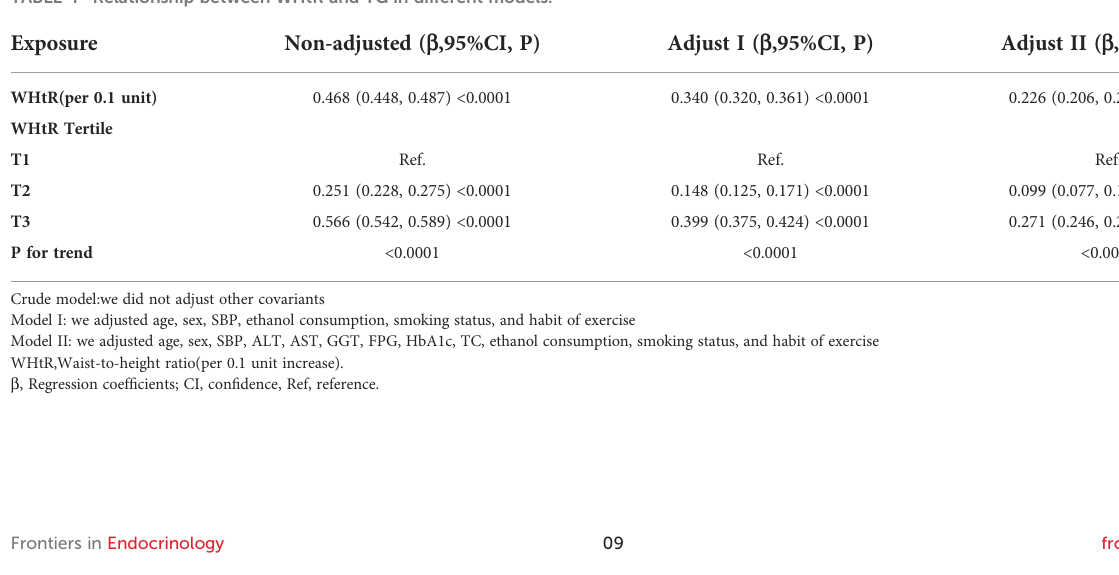
TABLE 4 Relationship between WHtR and TG in different models.